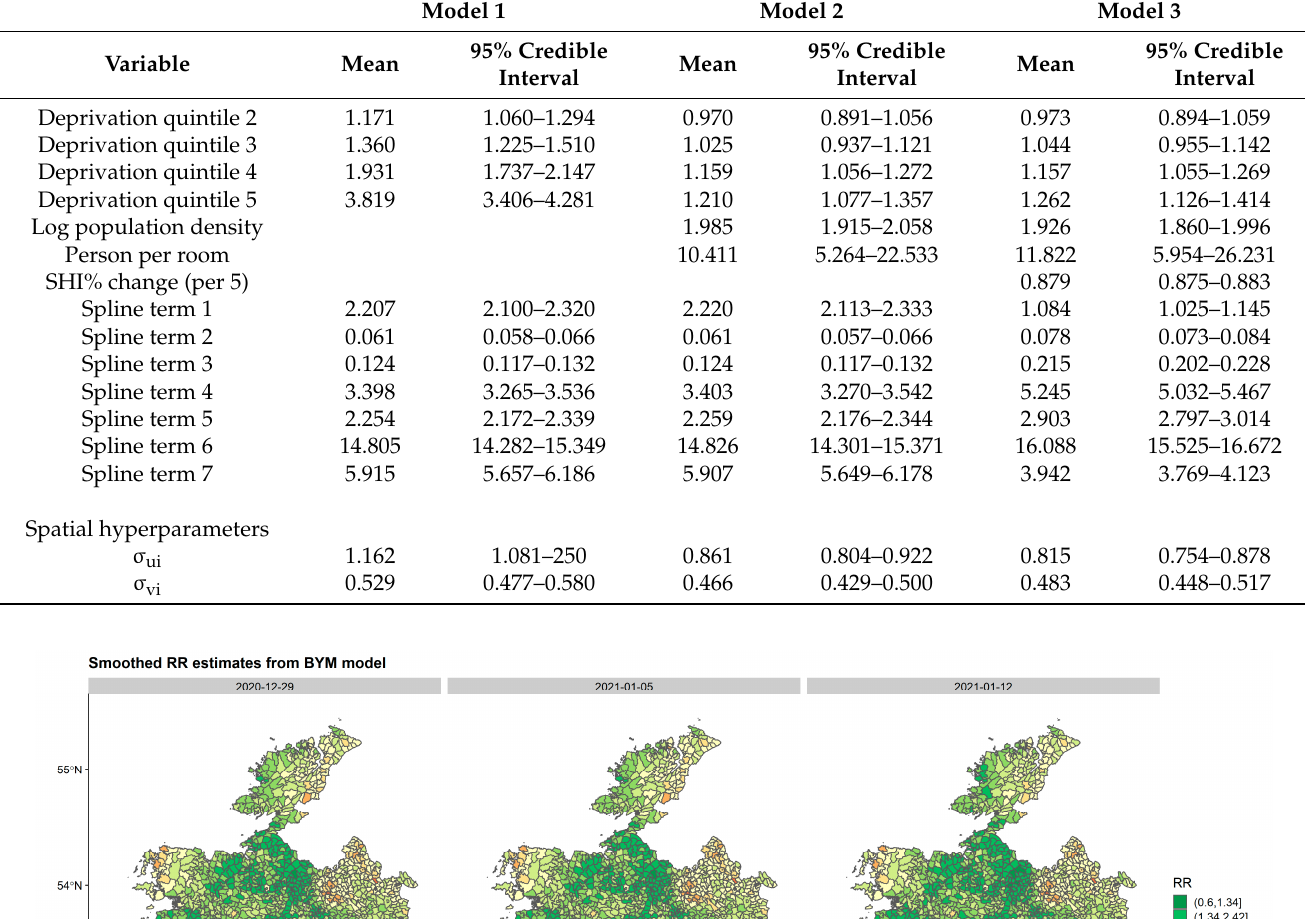
Table 3. Posterior means and 95% credible intervals from negative binomial BYM models.